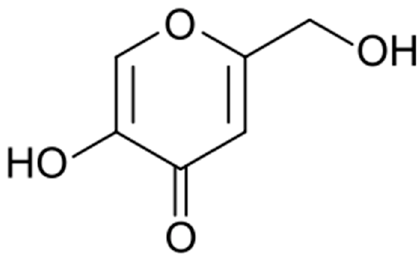
Figure 4. Kojic acid formula.